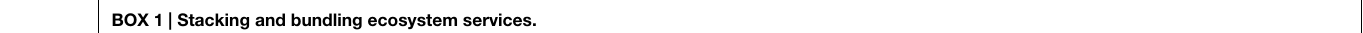
( Table 6 ). Designating “no-take-zones” to increase habitat cover and fish stocks, and compensating fishers for lost income is a strategy that some external non-governmental organization (NGO) donors have used (e.g., Kuruwitu Conservation and Welfare Association in Kenya—Mohammed, 2012). Setting up seagrass PES schemes requires research in a number of